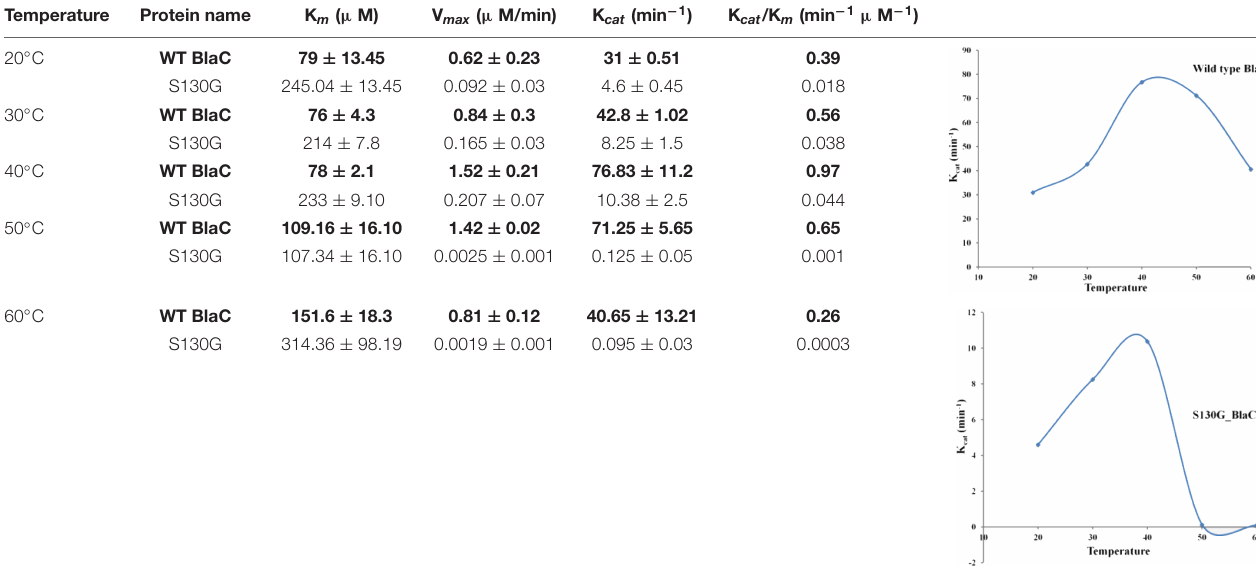
Table 3 | Temperature-dependent rate profiling of BlaC and its variant S130G beta-lactamase toward nitrocefin at variable temperatures.